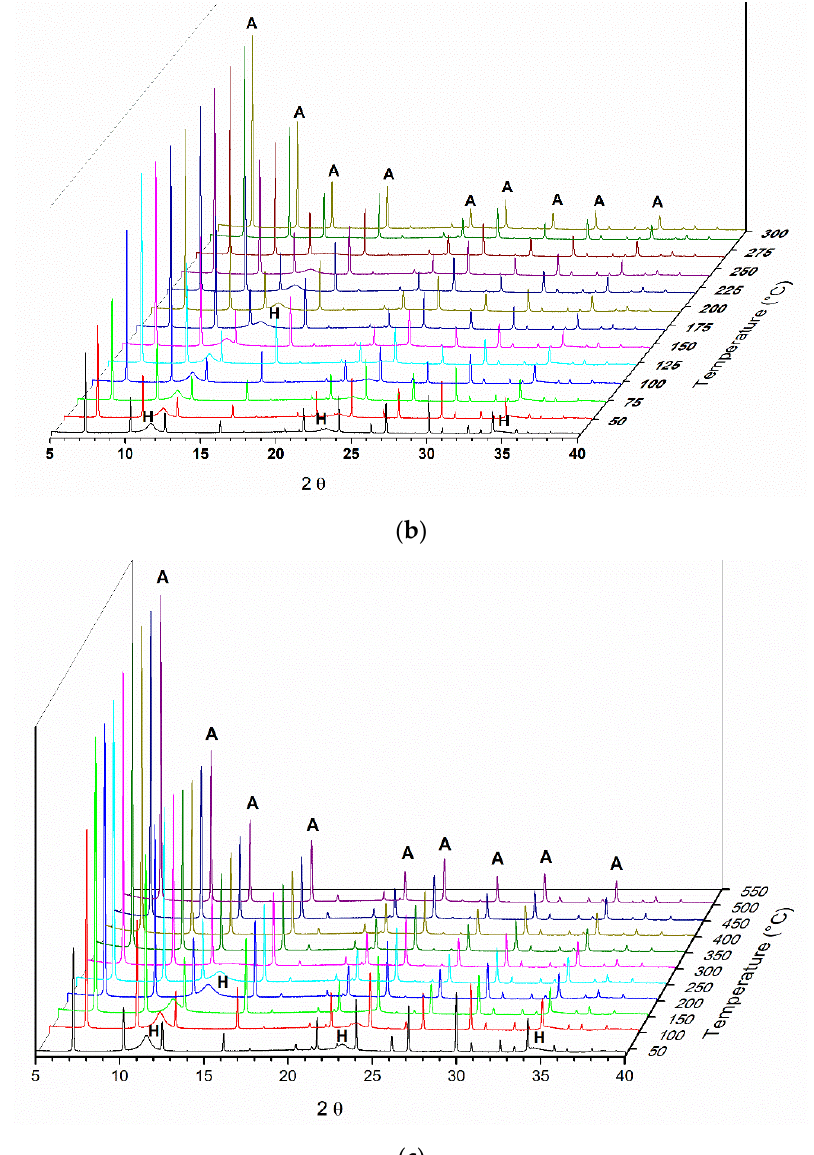
Figure 5. In situ diffractograms of the calcined samples: ( a ) under He flow at 300 °C, ( b ) under O 2 flow at 300 °C and ( c ) under O 2 flow at 500 °C. The symbol (A) indicates the reflections belonging to the zeolite A phase and (H) indicates the reflections referring to the hydrotalcite phase. The planes (003), (006), and (009) characteristic of the LDH phase are also indicated.